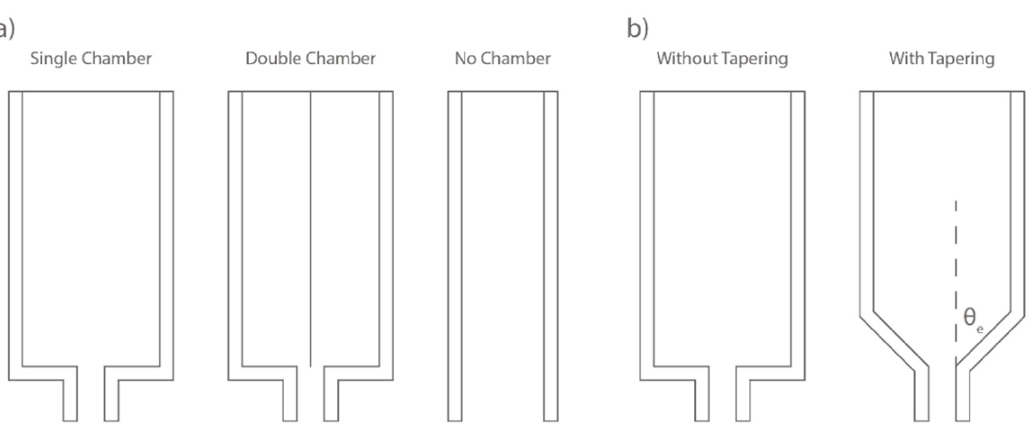
Figure 4. The schematic sketches of ( a ) chamber number: single chamber, double chamber and no chamber; and ( b ) chamber tapering: without tapering and with tapering.